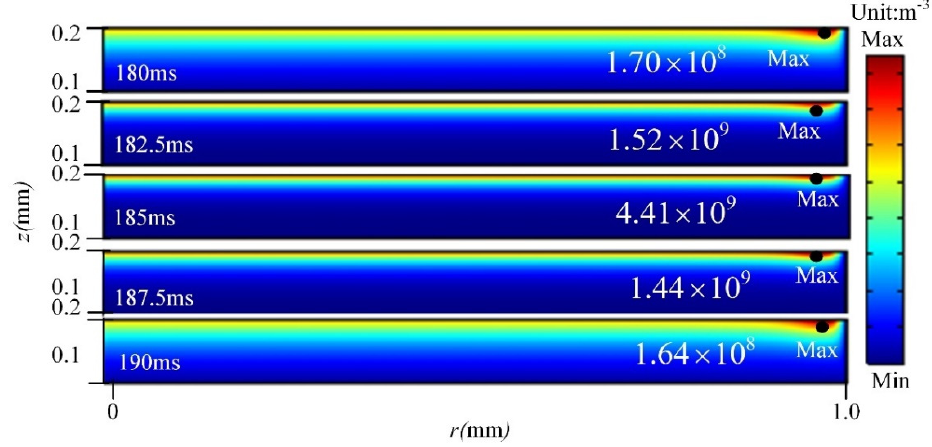
Figure 5. Evolution of spatial distribution of electron density in the 10th discharge air gap under composite voltage of 1:3.